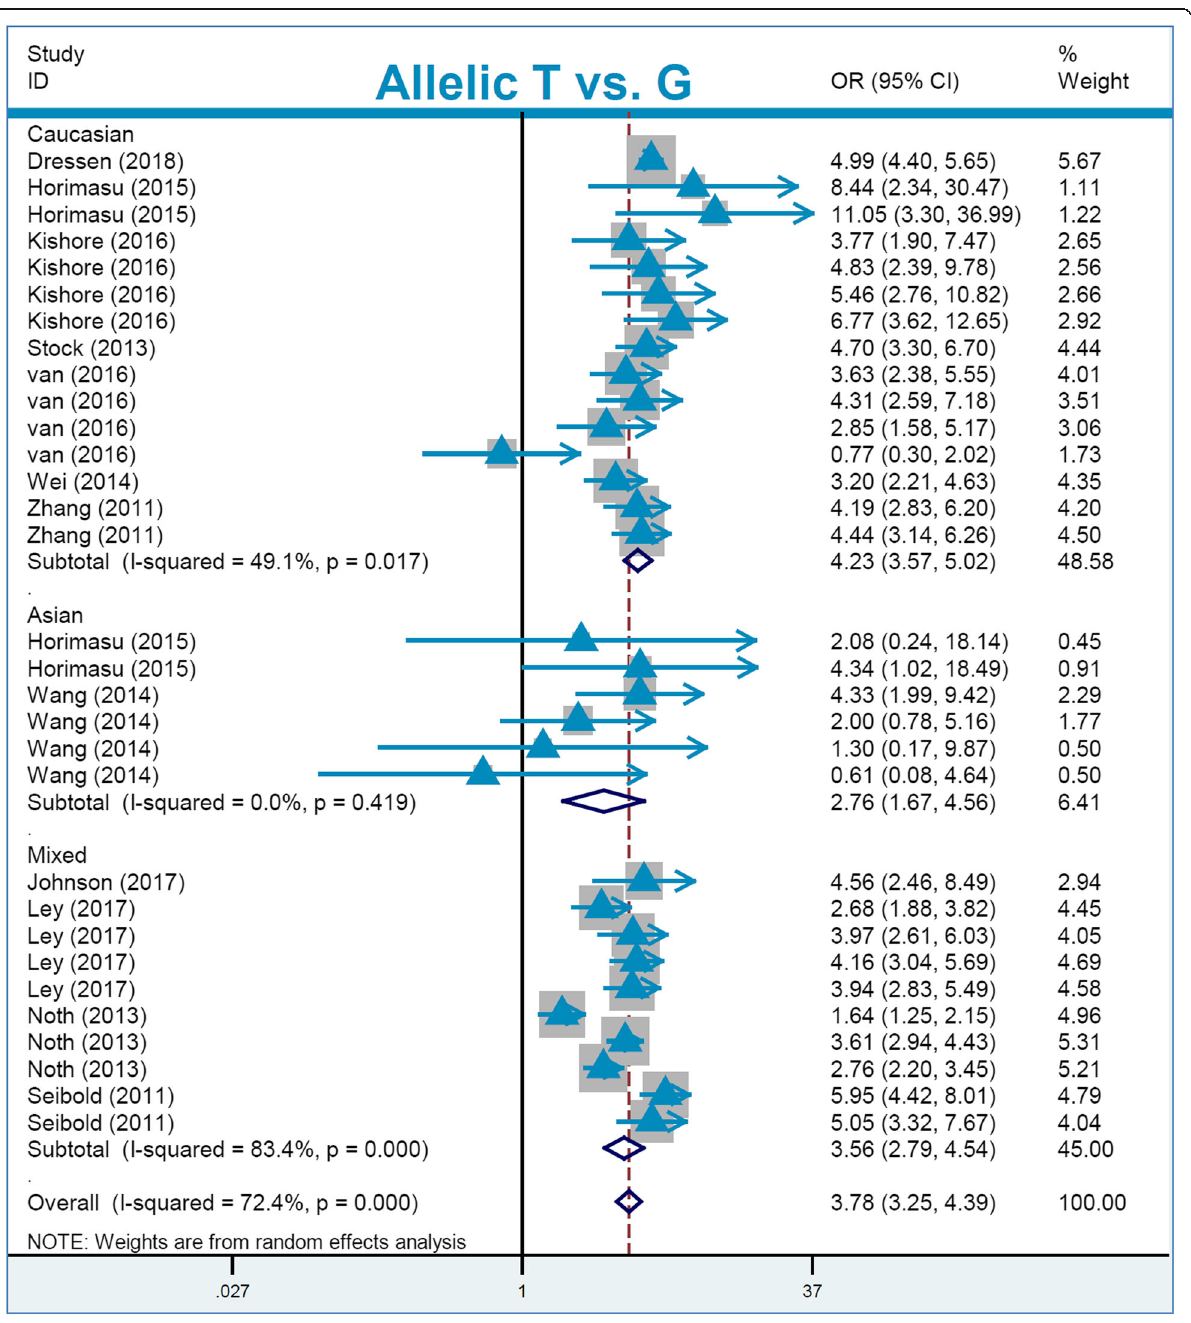
Fig. 3 Subgroup analysis of “ race ” for MUC5B rs35705950 under the allelic